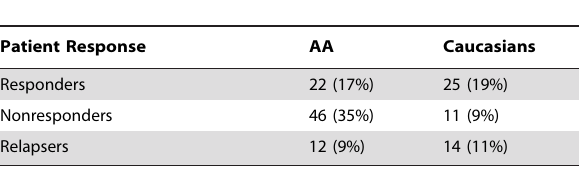
Table 4. Patient